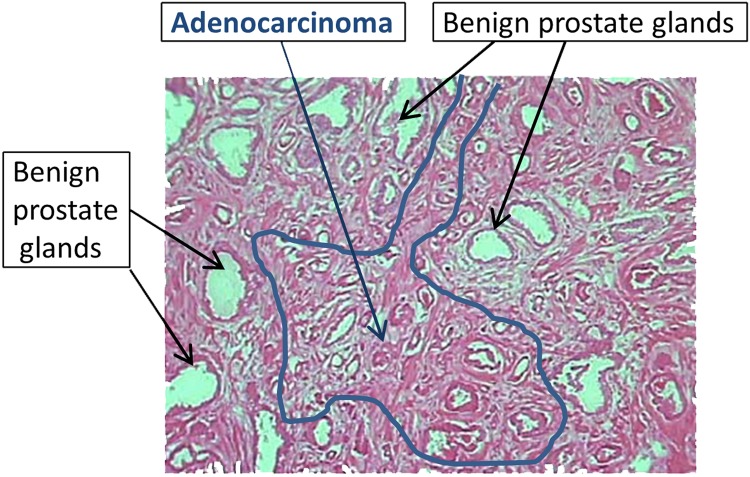
LCM is required to minimize variation due to tissue heterogeneity of human prostate tissue.This image of a frozen human prostate sample exemplifies the heterogeneity typical of human tissues: areas of adenocarcinoma, outlined in blue, are intermixed with stroma and benign prostate glands, labeled by arrows. LCM allows for targeted dissection of the malignant glands (scored as G3 and G4 for this particular sample) while avoiding the stroma and other benign structures.